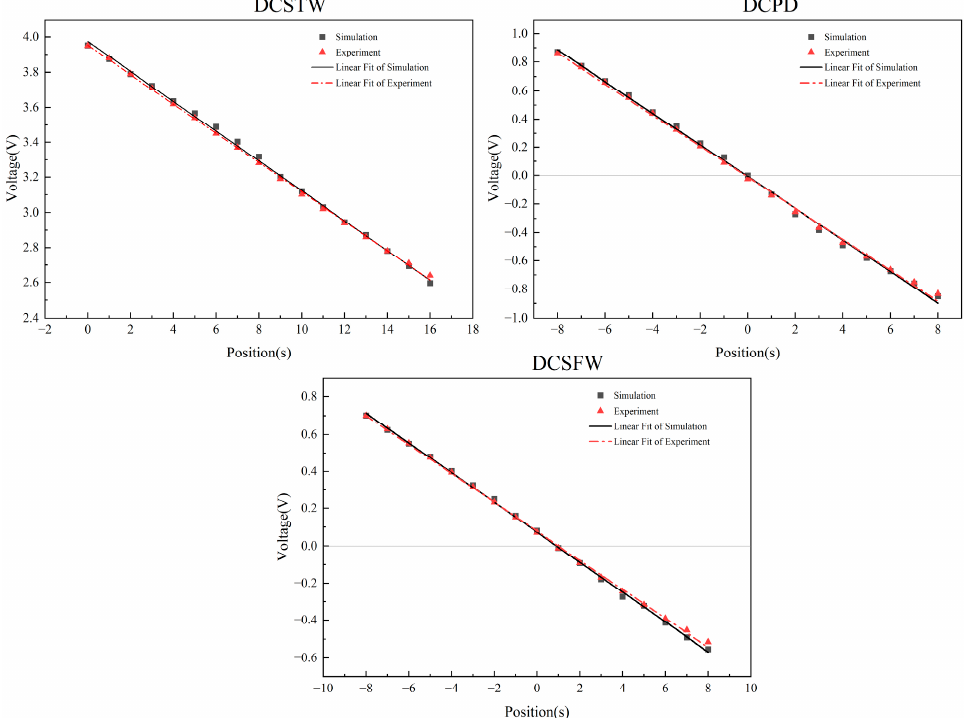
Figure 18. Simulation and experimental comparison of the three excitation methods.